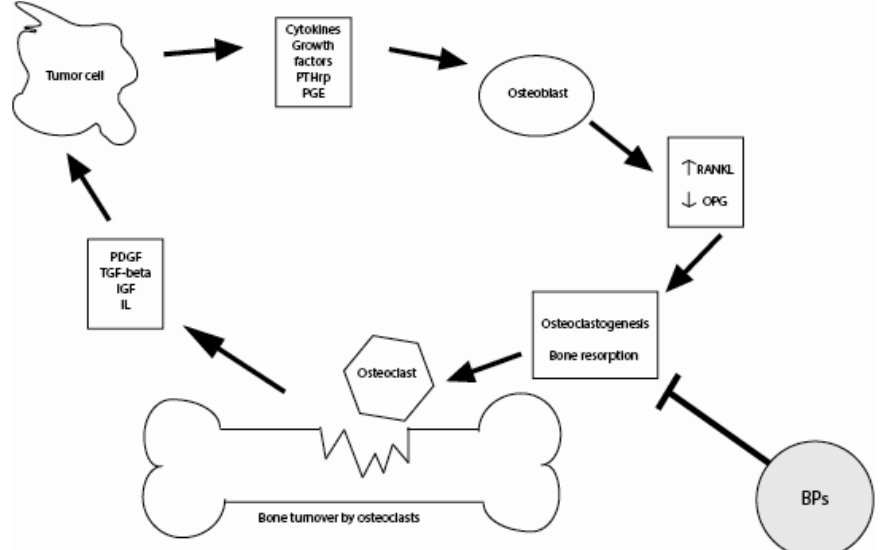
Figure 2. Schematic diagram of the interaction between the bone microenvironment and tumor